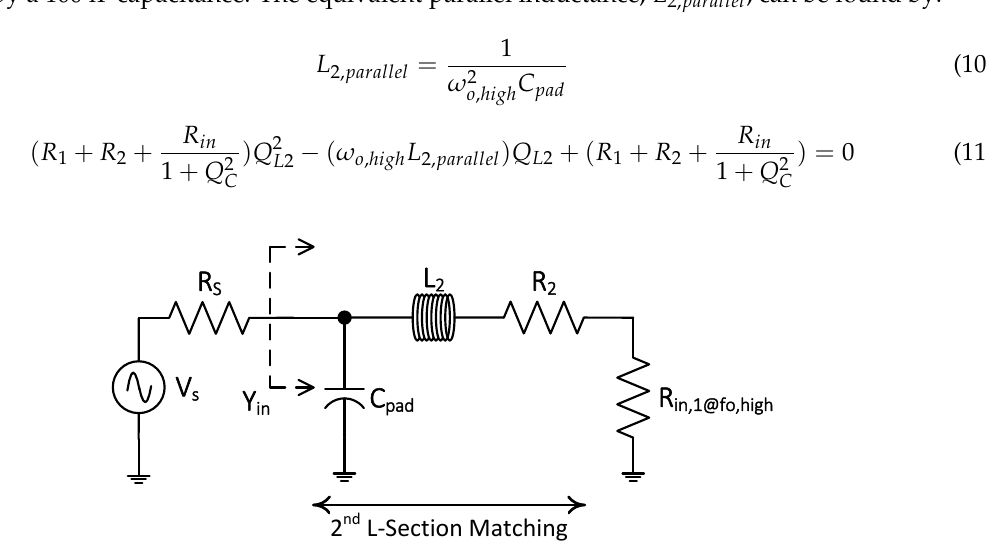
Figure 9. Desired circuit configuration at f o , high